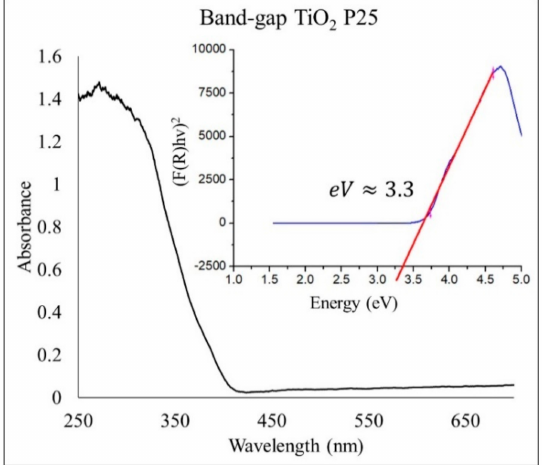
Figure 3. Band-gap calculation, according to the absorbance spectrum of TiO 2 P25, by means of the graphic representation [F(R)¯ h υ ] 2 against ¯ h υ of the Kubelka–Munk method.